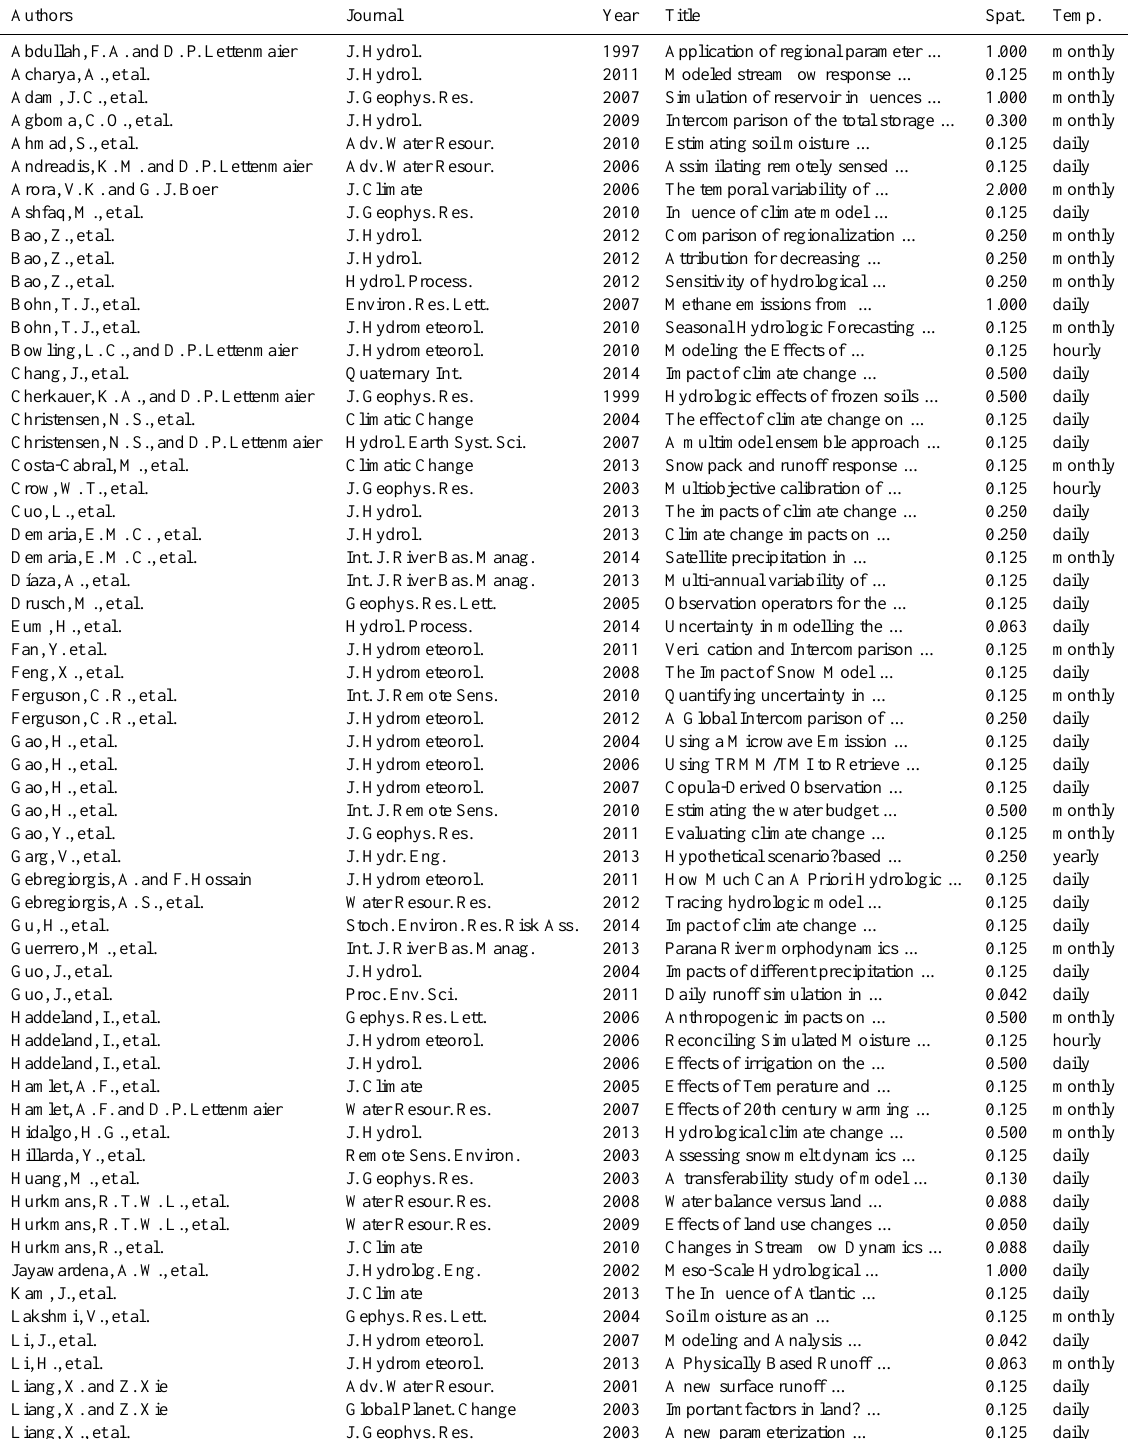
Table A1. All articles used to create Fig. 3, with their highest spatial resolution (Spat.; in degrees) and the time interval (Temp) used for calibration and